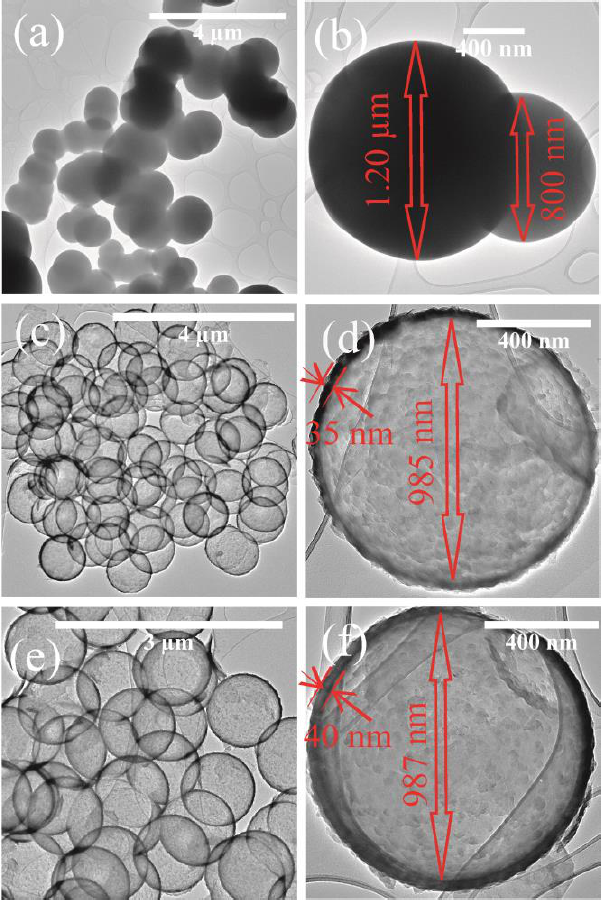
Figure 3. SEM images of ( a,b ) SCSs, ( c,d ) HCSs and ( e,f ) NHCSs (900 °C, 1 h reaction).